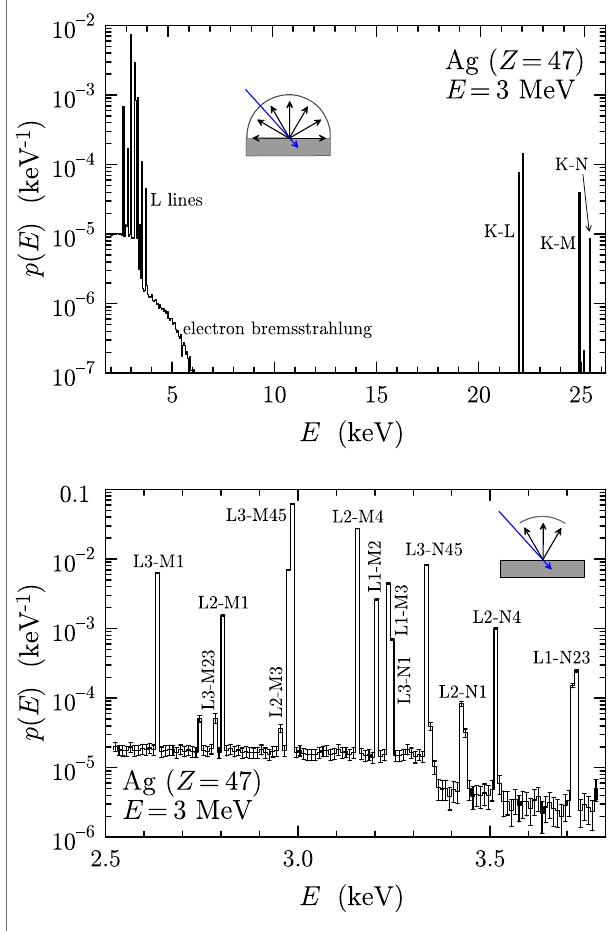
FIGURE 3 | PIXE spectra from a silver plate irradiated with 3 MeV protons incident at an angle of 45 ° to the surface. The upper plot is the spectrumobtainedbycollectingallphotonsthatemergefromthesurface.The spectrum in the lower plot is restricted to the energy interval of L x-ray lines; it was recorded by assuming a detector that only collects photons that emerge at angles less the 30 ° from the normal to the target.